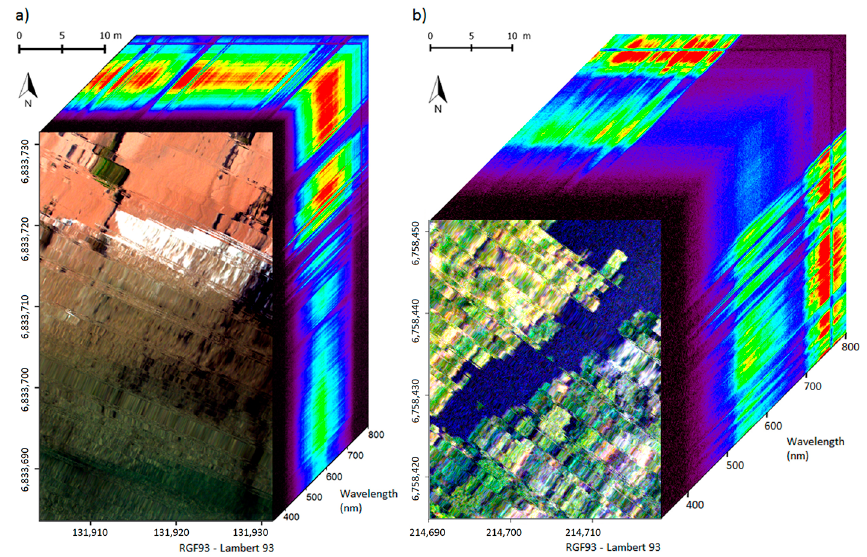
Figure 8. Hyperspectral cubes for Porsmilin Beach ( a ) and Lannénec Pond ( b ), located by the red boxes on Figure 7.